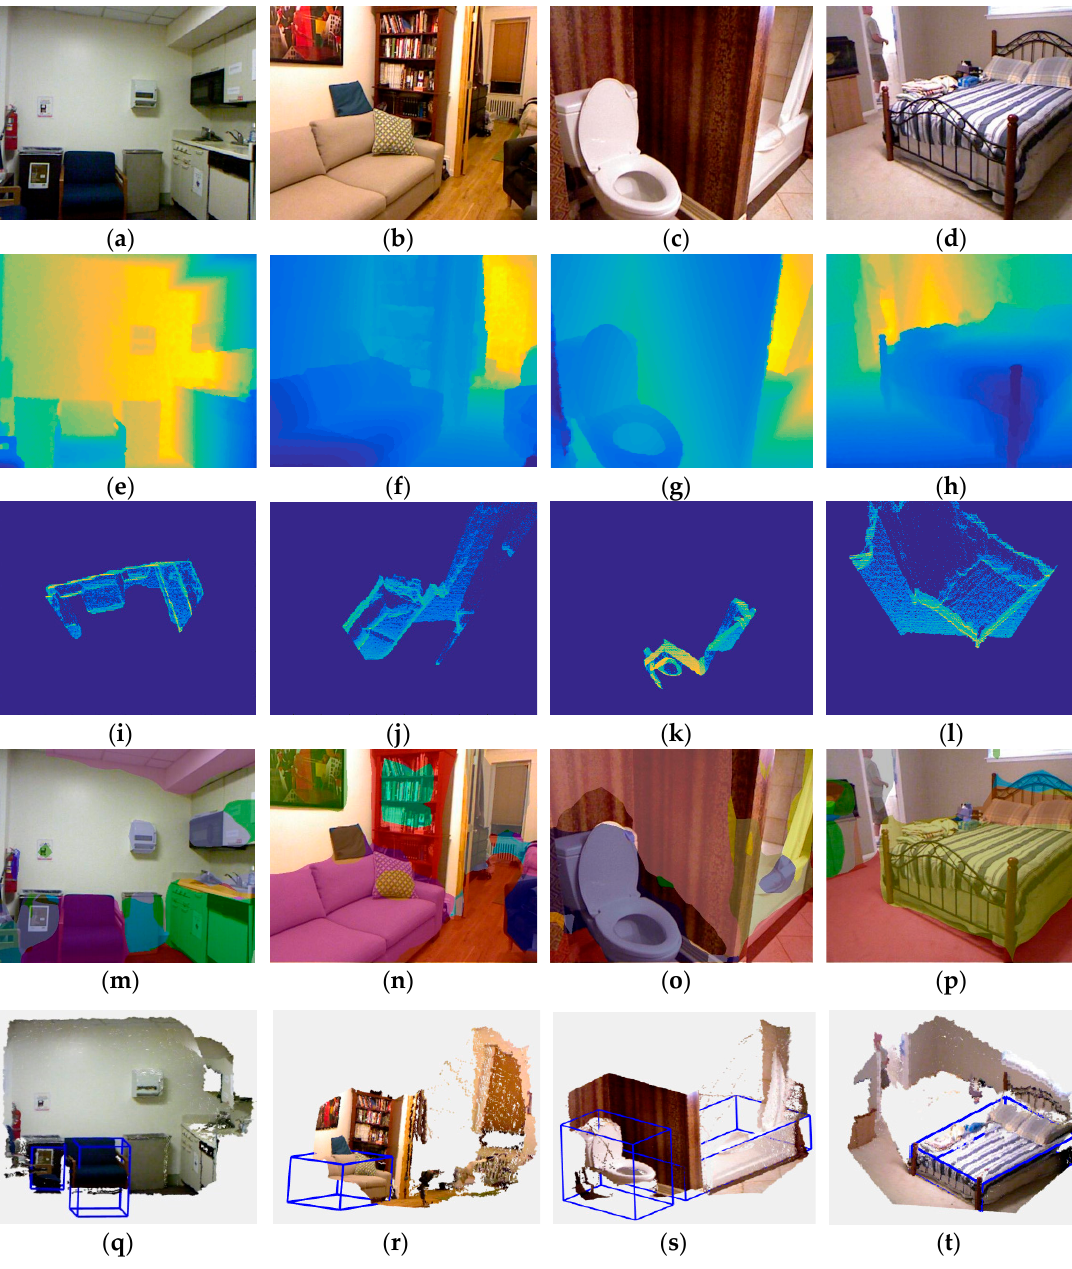
Figure 4. Experiments on the modified NYUV2 dataset where four different categories (chair, sofa, toilet, and bed) are detected. The first row ( a , b , c , d ) shows RGB images, the second row ( e , f , g , h ) shows depth images, the third row ( i , j , k , l ) shows BEV images, the fourth row ( m , n , o , p ) shows semantic images, and the last row (q, r, s, t) shows the point cloud with detected 3D bounding boxes. Table 3. 3D object detection comparisons on the SUN RGB-D dataset (mAP: mean average precision).